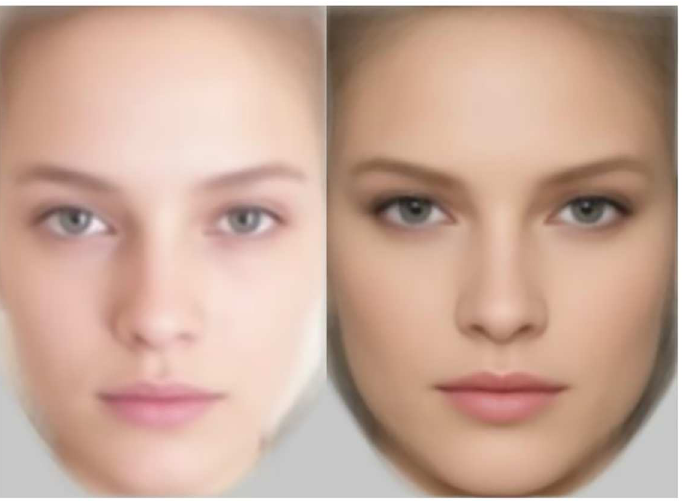
Fig 3. The average supermodel without (left) and with cosmetics